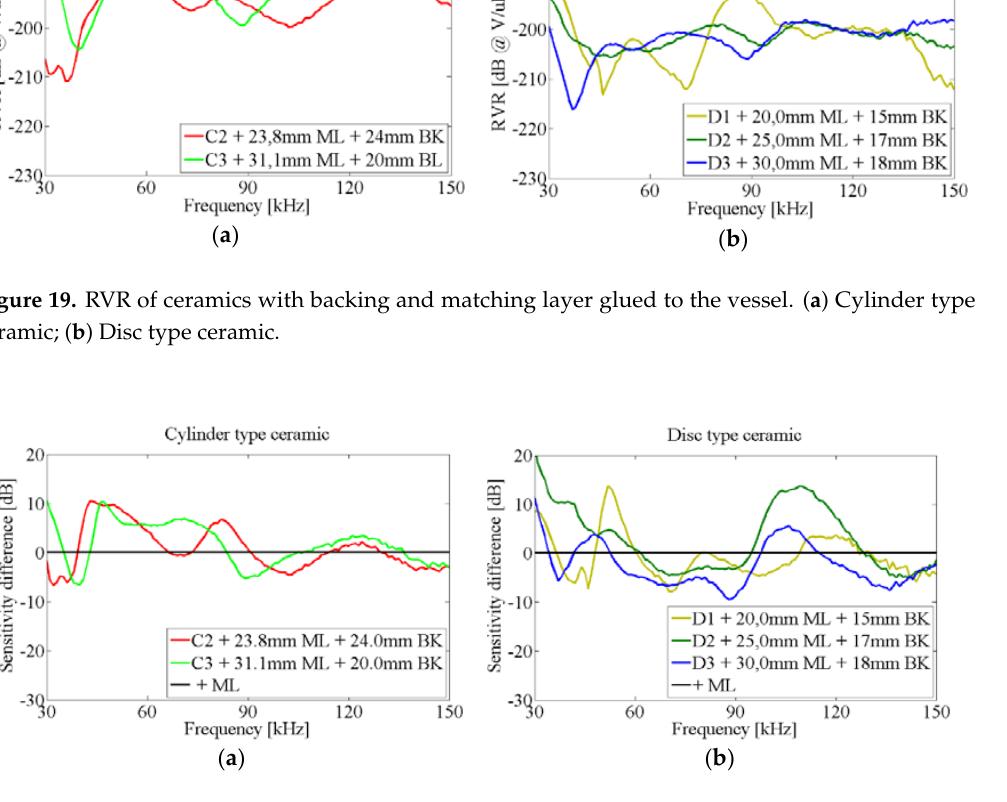
Figure 20. Difference of sensitivity in ceramics glued to the vessel, with and without backing. ( a ) Cylinder type ceramic; ( b ) Disc type ceramic.